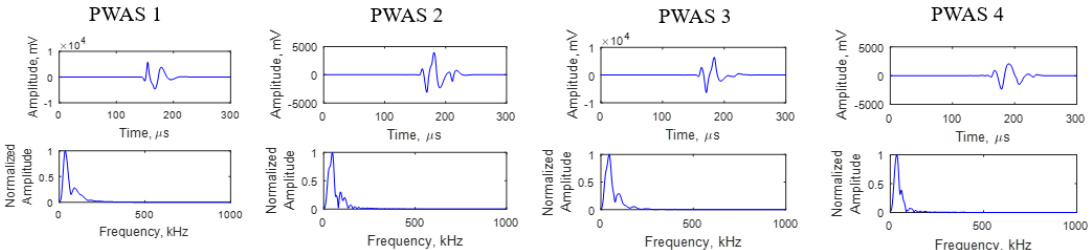
Figure 8. Signal correspondence at all four PWAS due to the 1st impact hit.